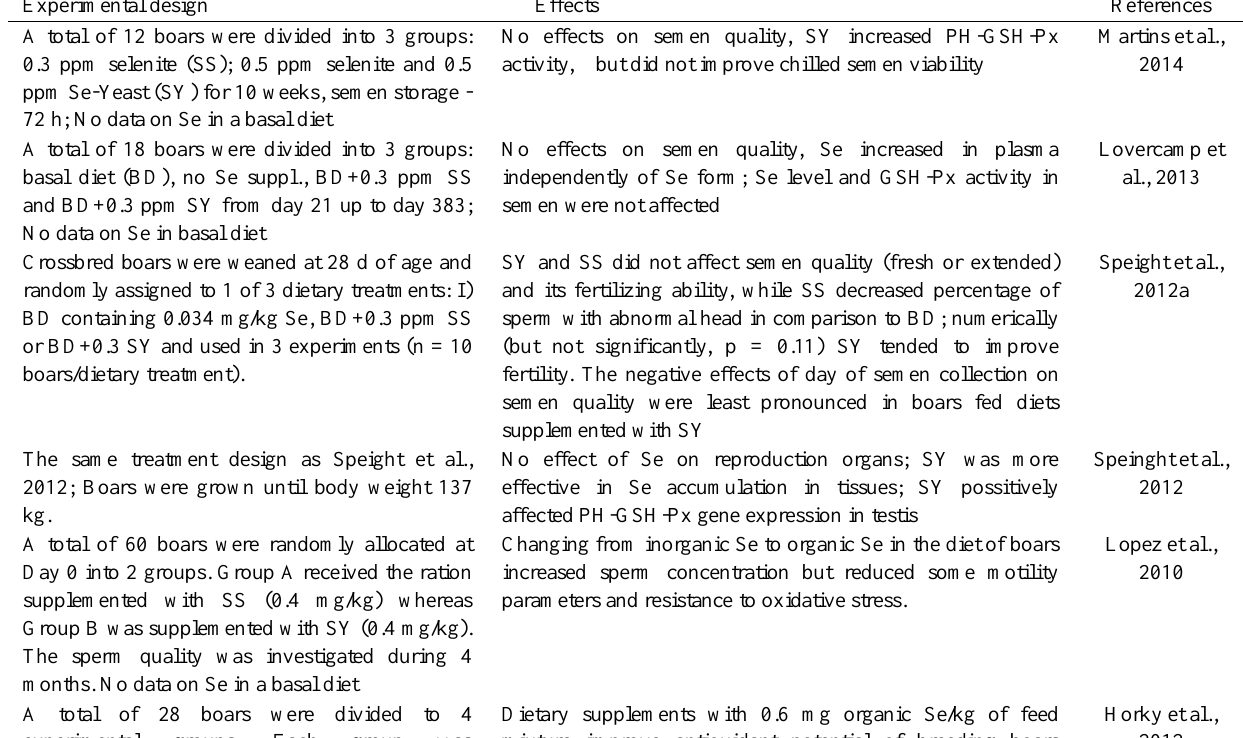
Table 2. Results of recent trials on effects of Se on boar reproduction Experimental